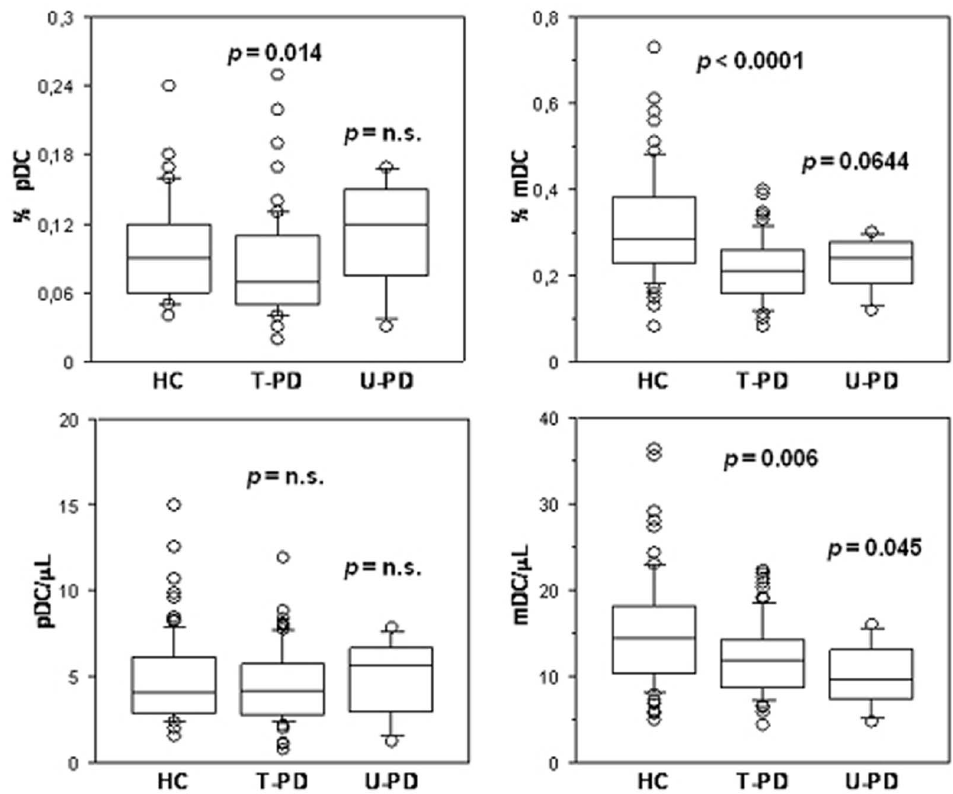
Figure 3. Blood DC decline in PD subgroups. The distribution of percentage values (upper panels) and total counts (lower panels) of pDC (left panels) and mDC (right panels) present in blood of HC (n=80), dopaminergic drug-treated PD (T-PD, n=73) and drug naı¨ve PD (U-PD, n=7) subjects is reported in the respective box-and-whisker plot, as indicated.